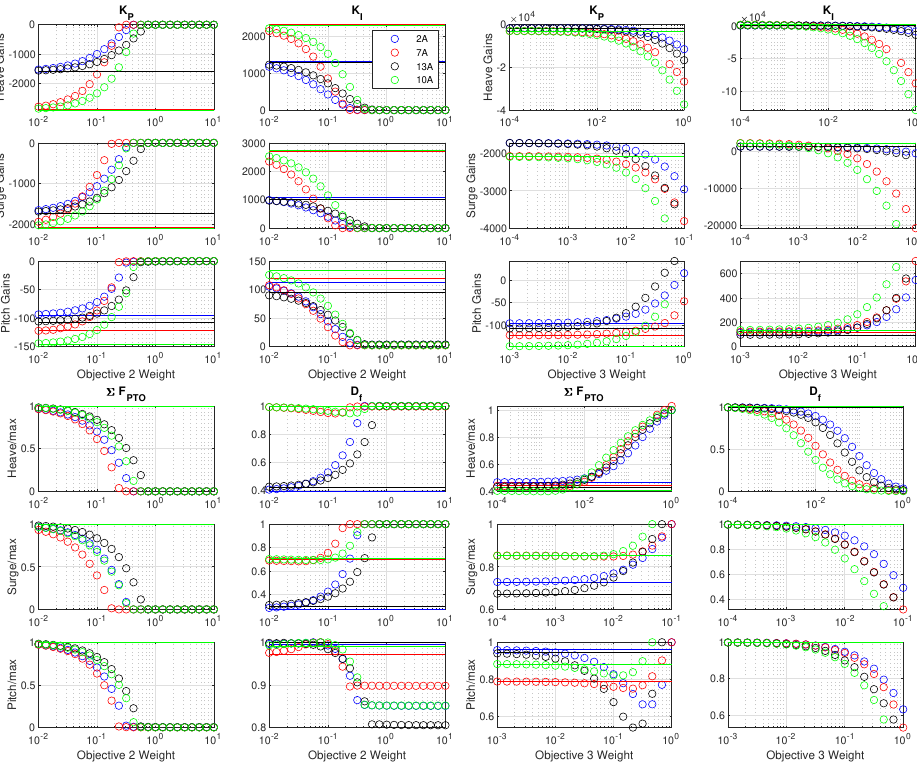
(cid:80) | F Fig. 13: Controller gains (top row) and PTO | and D f (bottom row) as a function of W 2 (left column) and W 3 (right column) for heave, surge, and pitch. To facilitate visualization for all sea states, the bottom row is normalized. The solid line indicates the plotted value at a weight value of zero, for comparison. For this study, W 3 = 0 when W 2 > 0 , and vice versa.